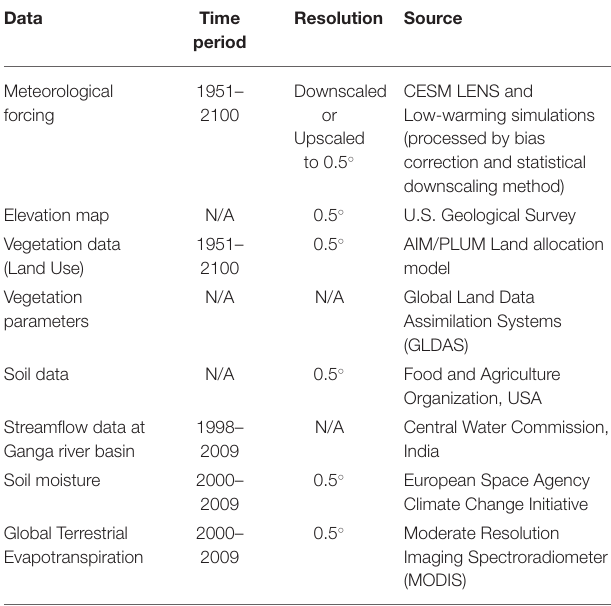
TABLE 2 | Datasets used in hydrological modeling or